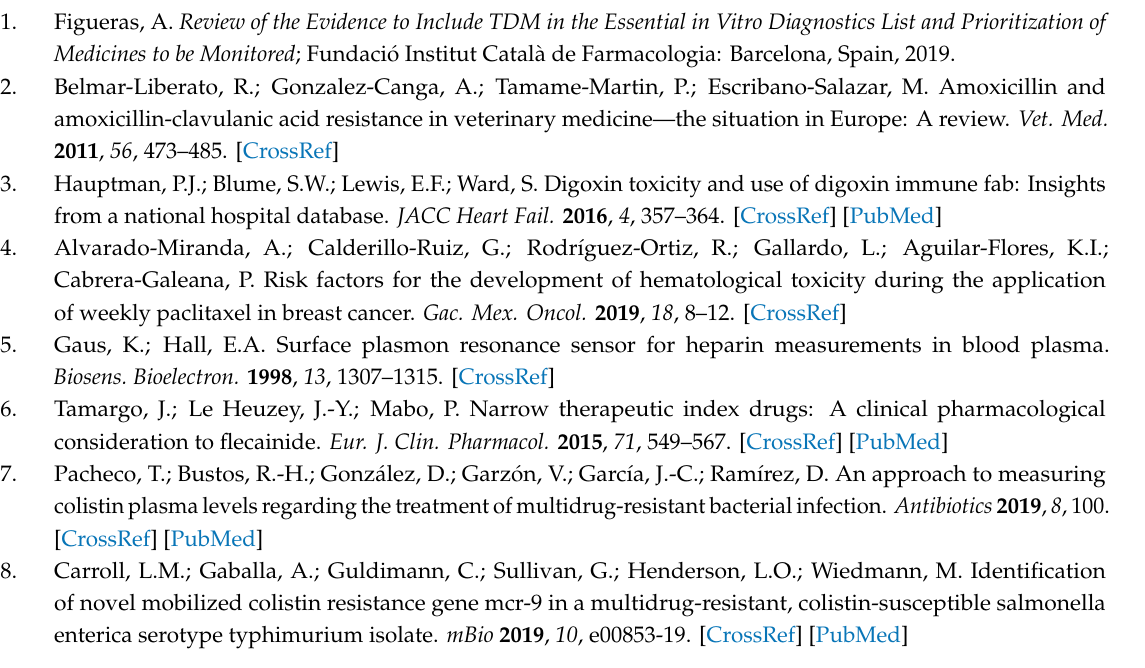
Figueras, A. Review of the Evidence to Include TDM in the Essential in Vitro Diagnostics List and Prioritization of Medicines to be Monitored ; Fundaci ó Institut Catal à de Farmacologia: Barcelona, Spain,